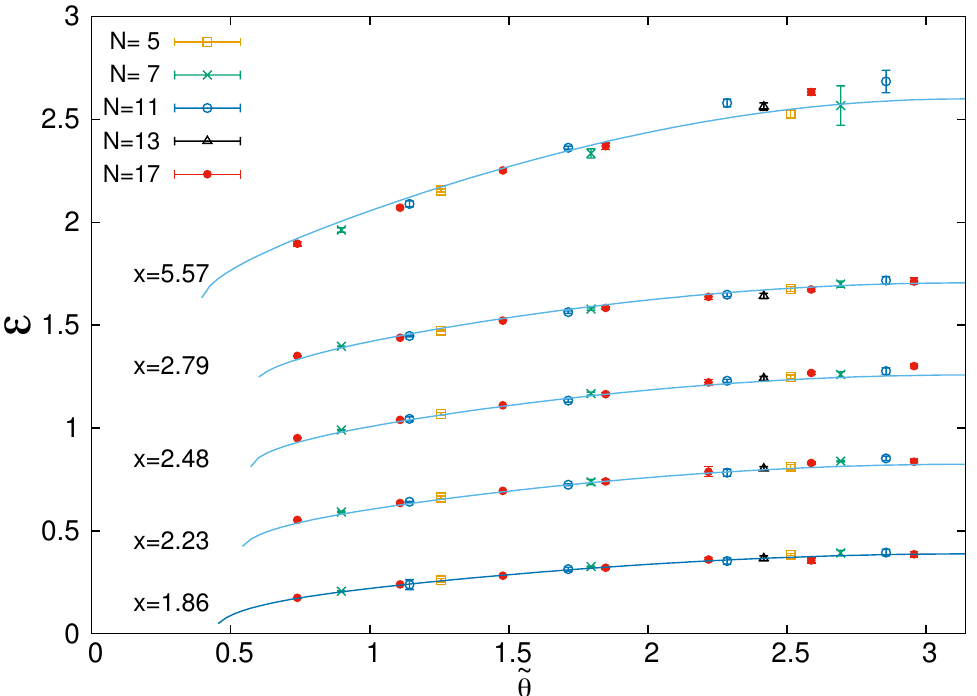
Figure 5. Dependence of E on the twist angle ~ (cid:18) de(cid:12)ned in eq. (2.13) for various values of x and (1 ; 0) N = 5, 7, 11, 13, 17. The results at di(cid:11)erent values of x are displaced vertically by 0.4 starting from the lowest displayed value of x . The continuous lines represent the parameterization in eq. (3.6) p with (cid:31) 0 = 0 : 6, and (cid:27) 0 =(cid:21) = 0 :